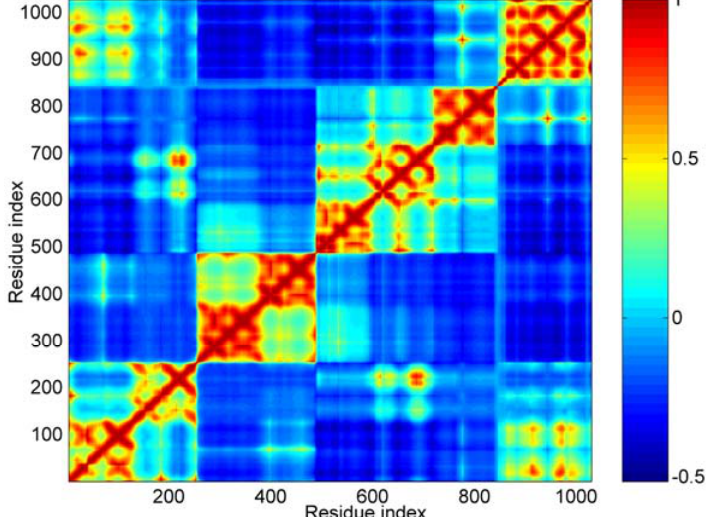
Figure 4. The cross-correlation maps calculated using the first 40 modes. Color ‘blue’ represents negative correlation and ‘orange-red’ positive correlation, as shown in the color bar on the right. Both the axis (x and y) of this map are residue